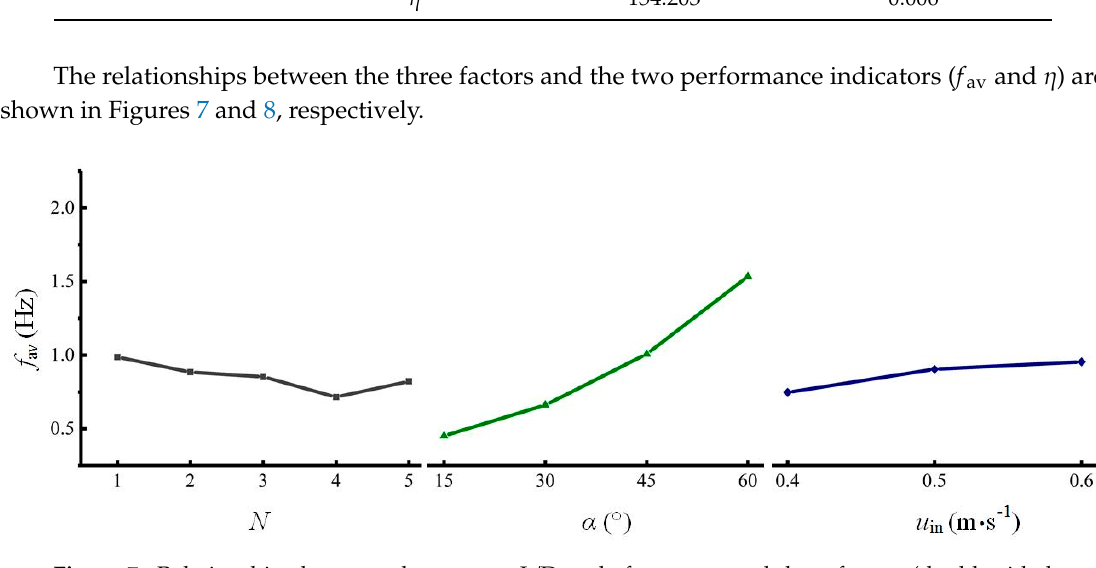
Figure 7. Relationships between the average L / D cycle frequency and three factors (double-sided illumination).